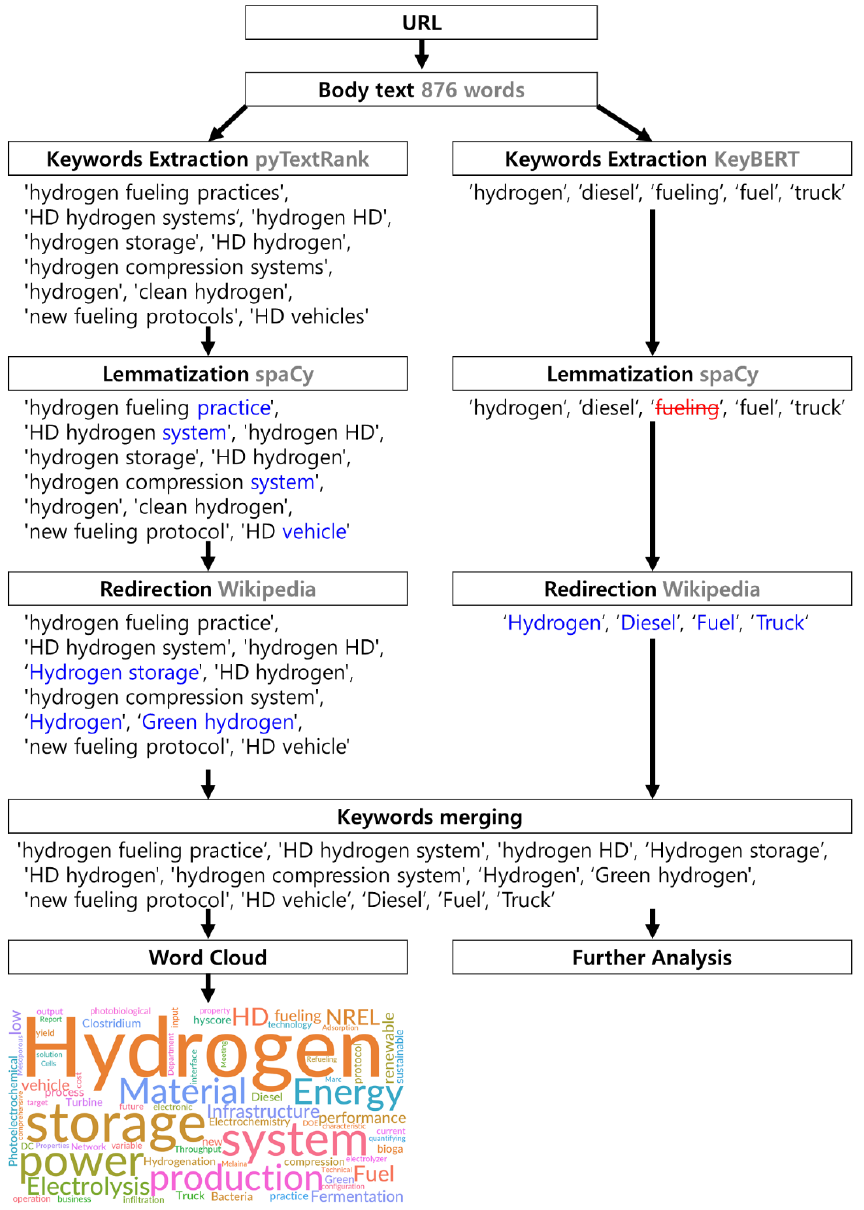
Figure 11. A flowchart of the keyword extraction process. The different approaches of pyTextRank and KeyPERT resulted different keywords, those are finally merged to form a word cloud and further analysis.